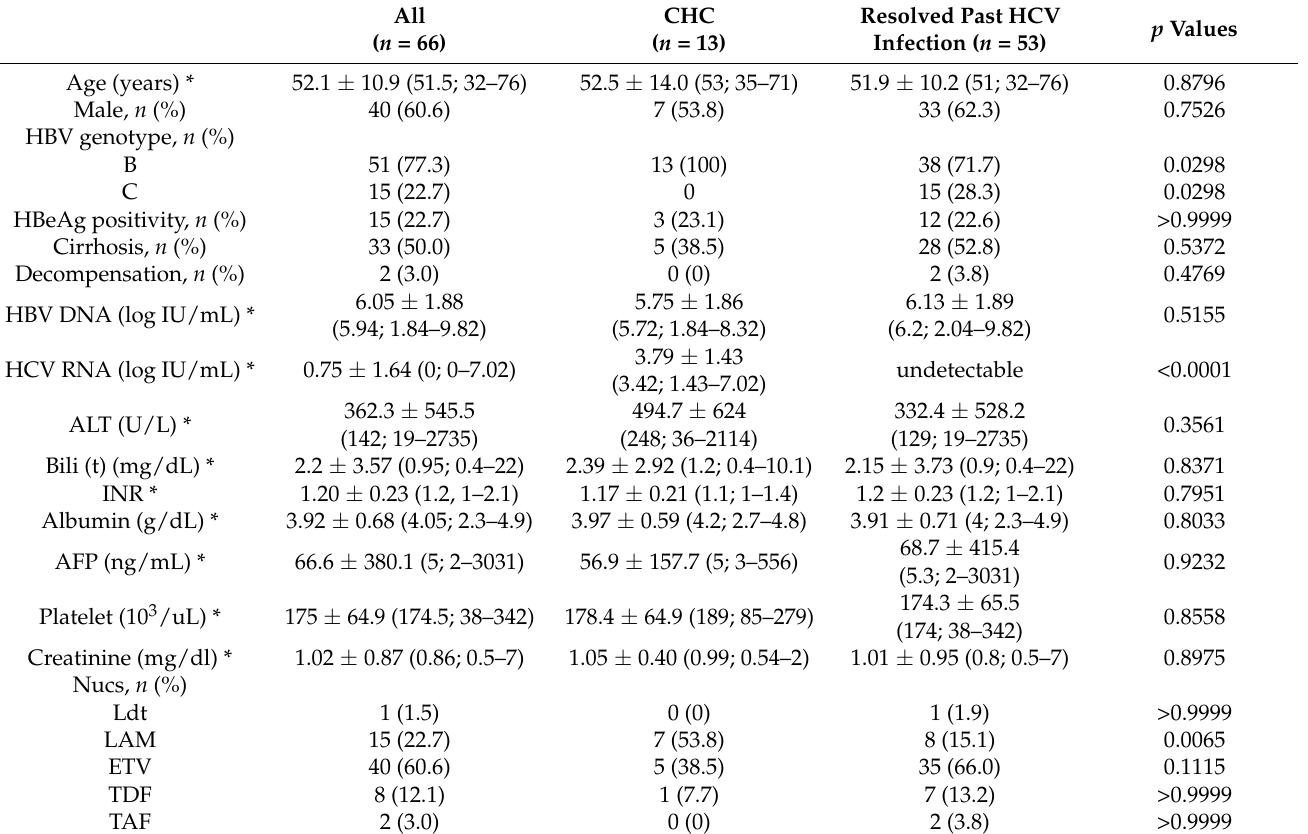
Table 1. Baseline characteristics of the enrolled CHB patients seropositive for anti-HCV